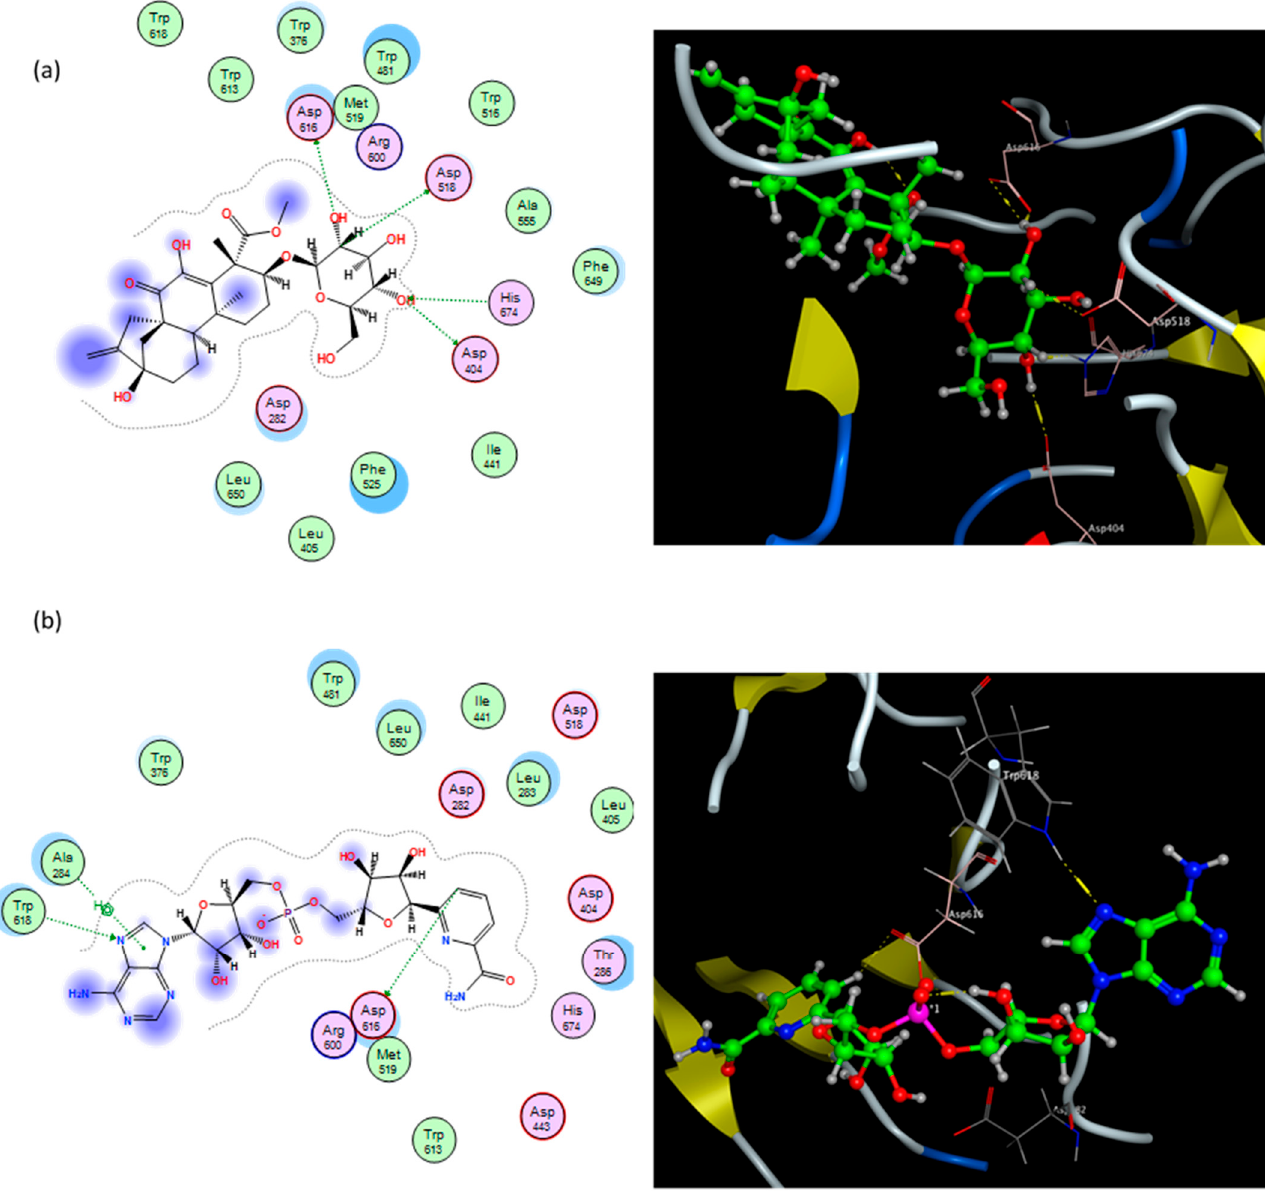
Figure 3. Binding modes of graecumoside A ( a ) and fenugreekine ( b ) into human α -glucosidase active site. In the 3D view (right side), ligands are depicted in the ball and stick model. The residues potentially interacting with the ligands are shown in labeled tube models; the dotted line indicates the formation of hydrogen bonds with amino acid residues. In the 2D view (left side), pink circles with red and blue borders indicate polar acidic and basic amino acids, respectively, and green circles indicate nonpolar amino acids.